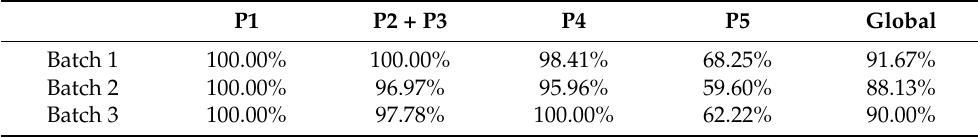
Table 7. Summary of tool performance idx tool results.